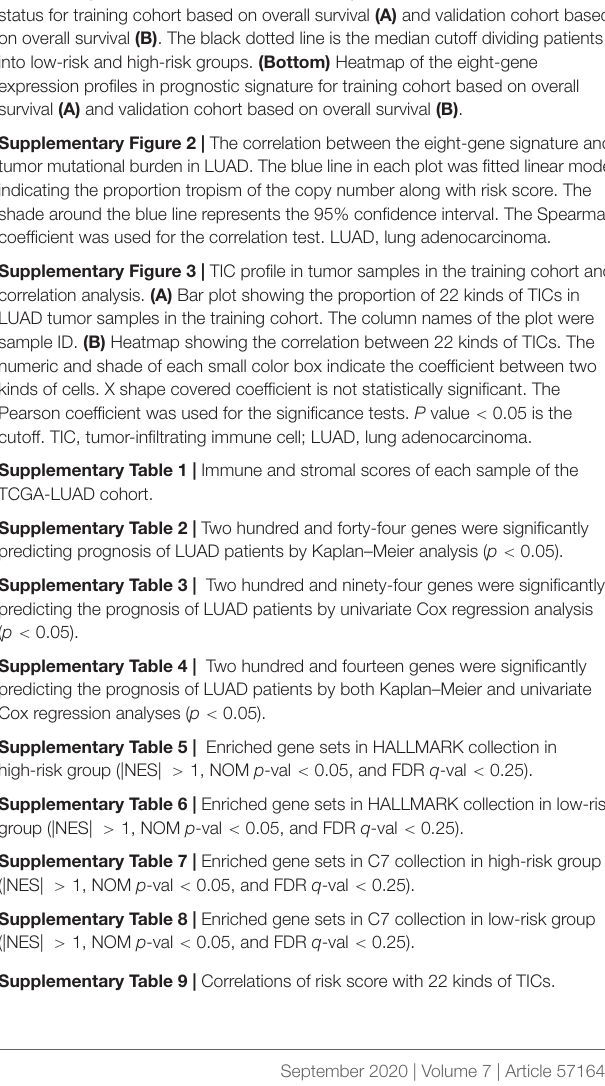
Supplementary Table 9 | Correlations of risk score with 22 kinds of